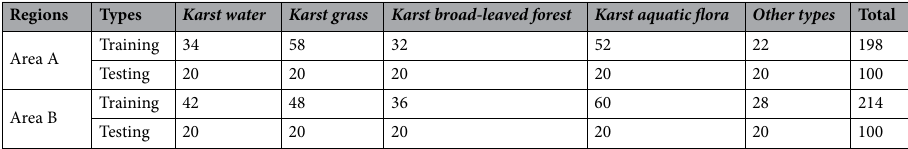
Table 1. Summary of the training and testing samples derived from vegetation